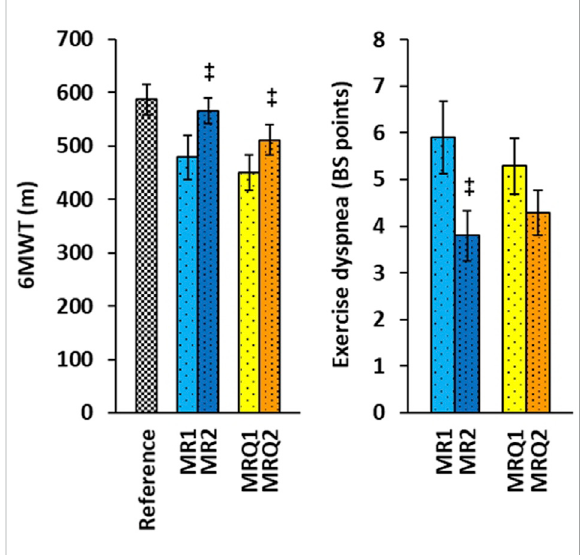
FIGURE 2 The effect of rehabilitation program on 6MWT and exercise dyspnea of patients with post C-19. Reference — the reference values for healthy subjects of age 50 – 59 years (Casanova et al., 2011). MR1, MRQ1 — the group of patients with post C-19 at the beginning of the study; MR2, MRQ2 — the groups of patients withpostC-19after16 – 18 daysofrehabilitationprogramwithout/ with CoQ 10 supplementation. + p < 0.05, ++ p < 0.01 vs. the same group at the beginninng of the study.